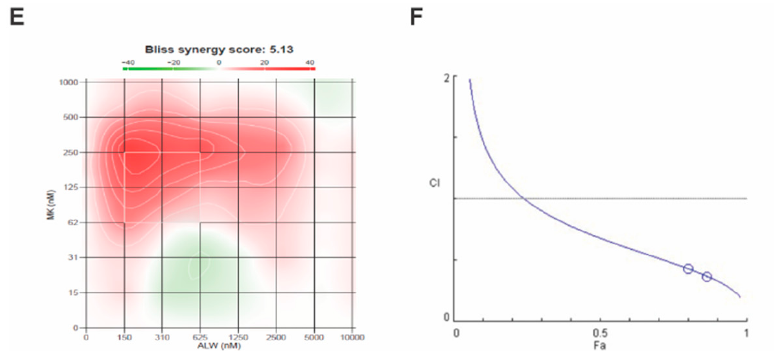
Figure 1. High–throughput screen for synergistic partners for EphA2–targeted therapy and verifi- cation of Wee1 as a target. ( A ) Top 10 hits from the chemical screen. ( B ) Effect of EphA2 silencing on Wee1 activity, as seen by phosphorylation of cdc2, in Hec1A cells. ( C ) Dose–response matrix for combinatorial analysis of the EphA2 inhibitor ALW and Wee1 inhibitor MK1775. ( D ) Difference from predicted Bliss independence surface model for the combination of ALW and MK1775. ( E ) Visualiza- tion of the calculated 2D synergy maps for the MTT cell viability assay from the SynergyFinder Bliss independence model combinatorial analysis. Red regions represent synergy, and green regions repre- sent antagonism. ( F ) Plots showing fraction of cells affected (Fa) and combination index (CI) values for ALW and MK1775. The white circles representing the CI values of the ALW:MK1775 combination (1 µM:0.5 µM and 1 µM:0.75 µM concentrations, respectively) were less than one, indicating synergy.